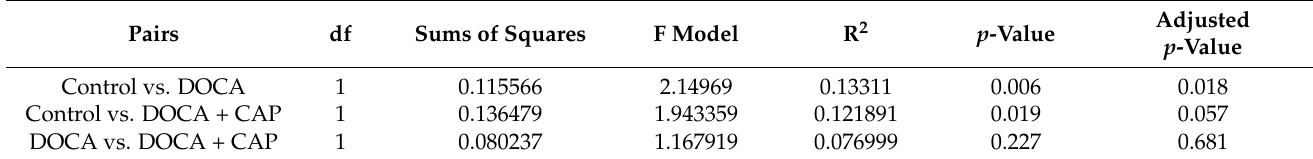
Table A1. Table of PERMANOVA of the 16S bacterial genus abundance comparison among the Control, DOCA, and DOCA + Captopril groups.